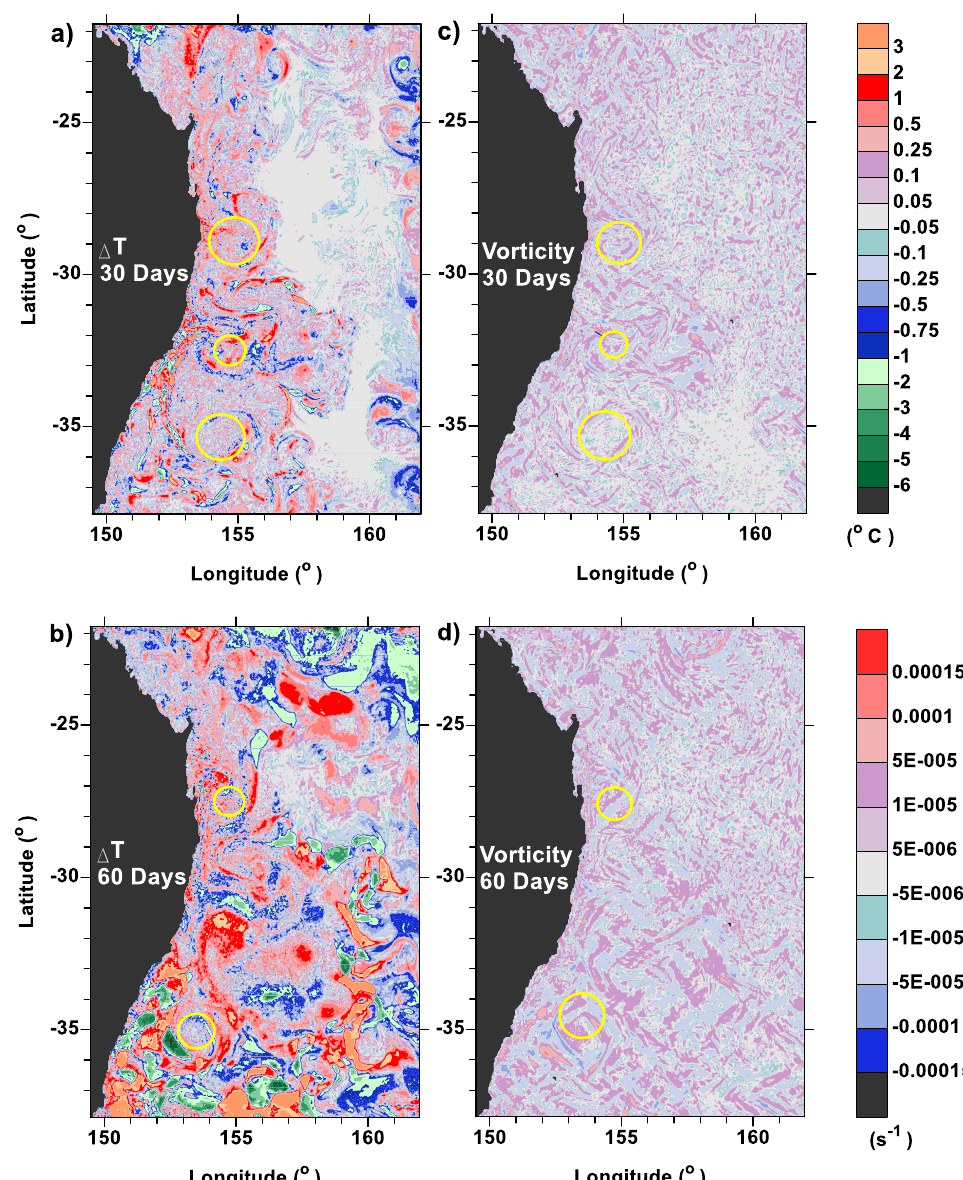
Fig. 9 Surface differences in temperature at a 30 and b 60 days and vorticity at c 30 and d 60 days. Approximate eddy edge locations are indicated by yellow